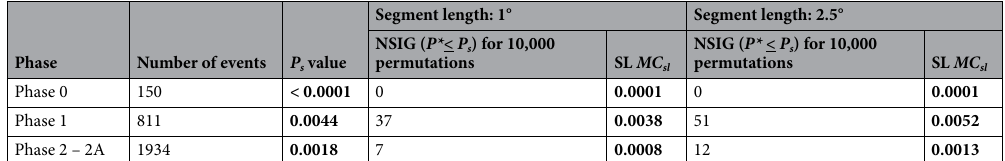
Table 3. Results of the application of Schuster’s test and a Monte Carlo permutation test (10,000 simulations) to Phase 0 , Phase 1 and Phase2-subset 2A (see “Methods” for a description of the permutation test). P s is the probability that the phase angle distribution in the original catalogue to be random, according to Schuster’s test. For each permutation, a Schuster probability value P* is obtained. NSIG is the number of permutations where P* < P s for each cluster. SL means “significance level”. MC sl is the significance level of the permutation test, as explained in the “Methods” section. Different segment lengths were applied. Occurrences where P s < 0.05 or MC sl < 0.05 are in